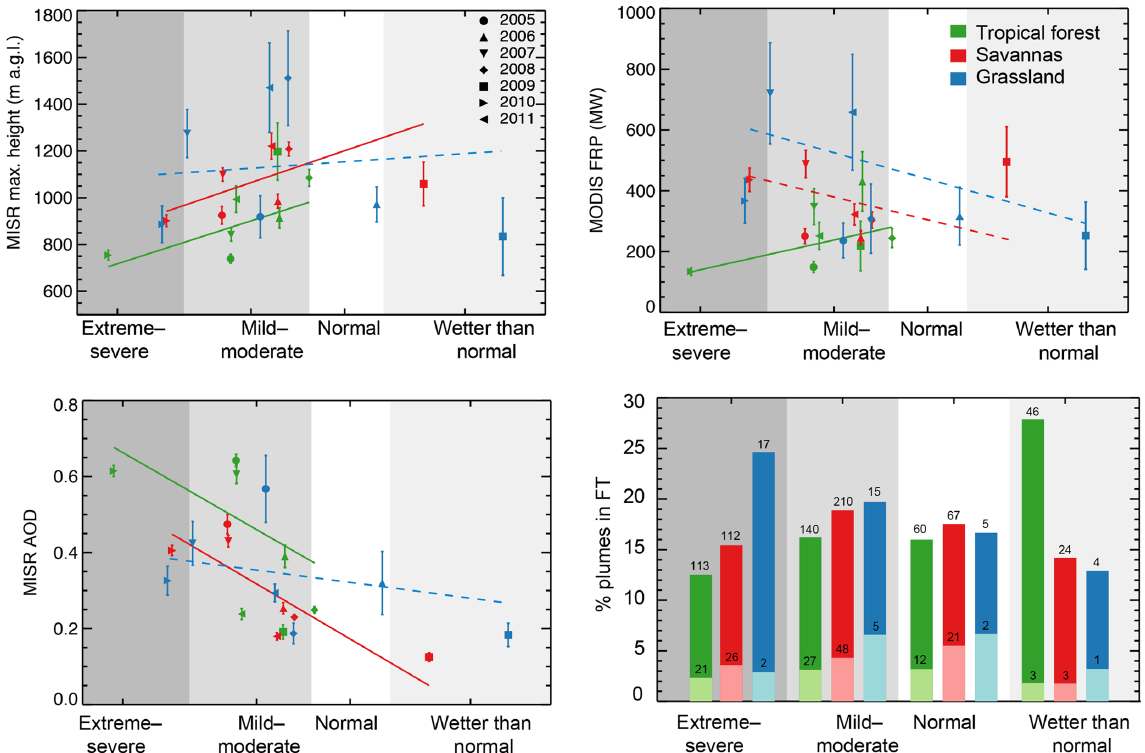
Figure 8. Relationship between MODIS DSI at the location of the plumes and MISR maximum plume height, MODIS FRP and MISR AOD annually averaged, for tropical forest (green), savanna (blue) and grassland (red). Symbols represent the annual average and bars the standard error of the mean. Regression lines are weighted by the number of plumes in each year; relationships with absolute r < 0 . 4 are plotted in dashed lines. Also included is the percentage of smoke plumes in the FT in each biome and by drought condition. Bar plots indicate the average of (median plume − PBL height) > 0.5km (light colour) and (maximum plume − PBL height) > 0.25km (dark colour), based on MERRA-2 PBL heights (see text for